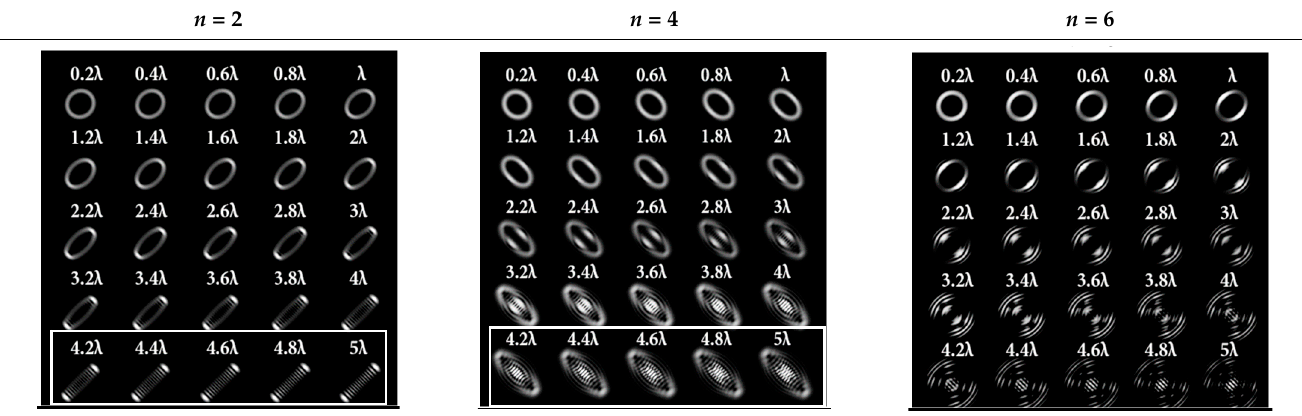
Table 7. Simulation results for multi-channel DOE matched with one type of aberration Z n ,2 ( r , ϕ ) ( n = 2, 4, 6) with α ranging from 0.2 λ to 5 λ when illuminated with a vortex beam with T С l = 14.